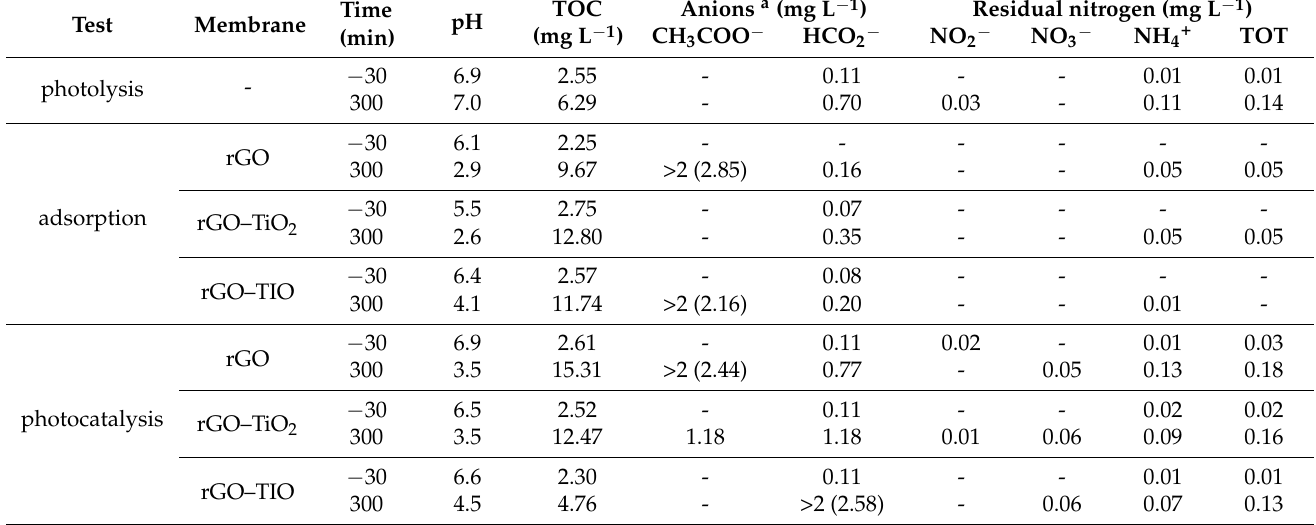
Table 5. The pH, total organic carbon (TOC), and species detected by ion chromatography (IC) in the Imidacloprid ® solution before ( − 30 min) and after (300 min) testing with rGO, rGO–TiO 2 , and rGO–TIO